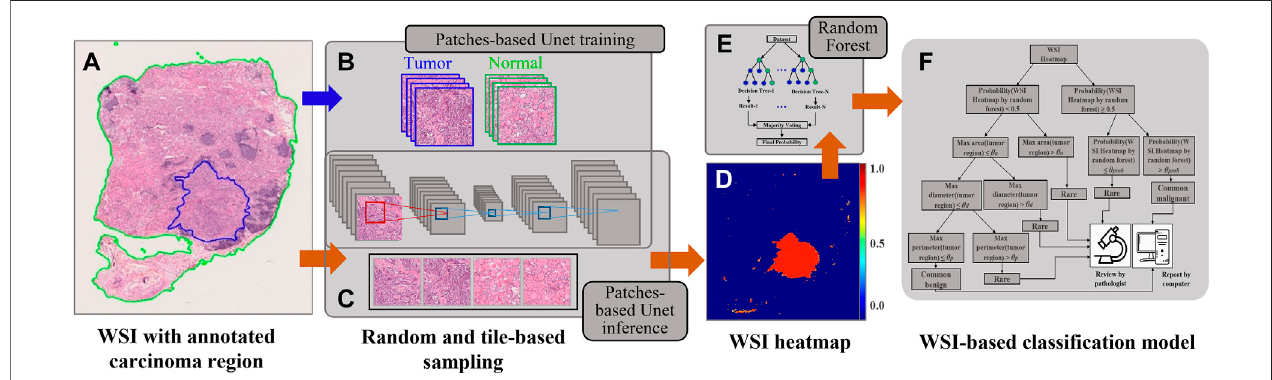
FIGURE1| Anoverview oftheproposedWSIdiagnosticframeworkpresentedinthisstudy. (A) TheWSIslidewiththeregionofinterest(green line)andcarcinoma region (blueline). (B) The process of patch-based UNetmodel training. (C) The process ofpatch-based UNetinference. (D) The WSI heatmap. (E) Arandomforestwas selected for the WSI-based classi fi cation task. (F) The proposed triple classi fi cation model.